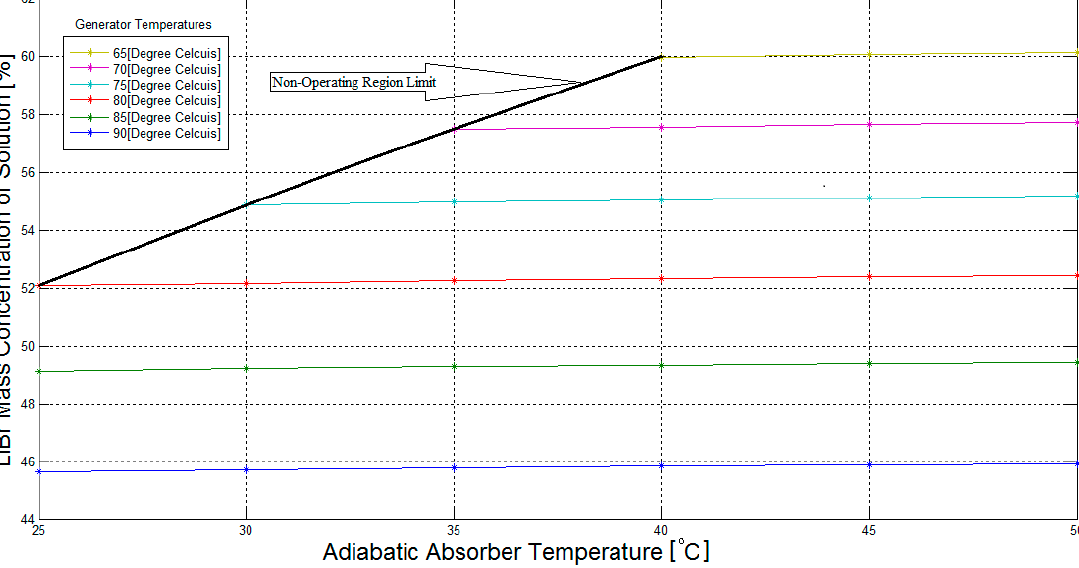
Figure 6. Graph showing the variation of the heat input in the generator, with adiabatic absorber temperature and generator temperature ((cid:1846) (cid:3030)(cid:3042)(cid:3041) = 35 ℃, (cid:1846) (cid:3032)(cid:3049)(cid:3028) = 10 ℃) .